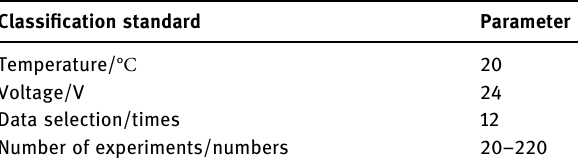
Table 1: Experimental condition